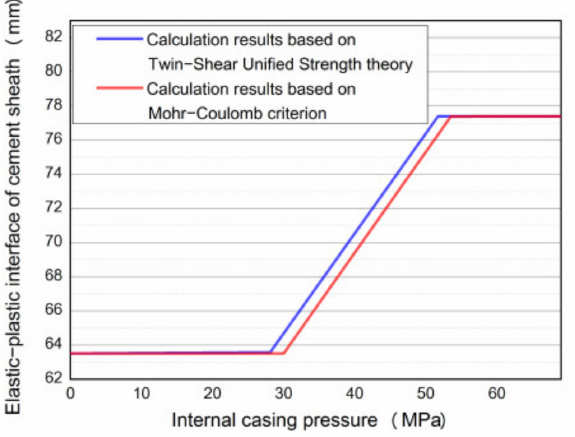
Figure 4. Development of elastic–plastic boundary of cement sheath under different yield criteria.